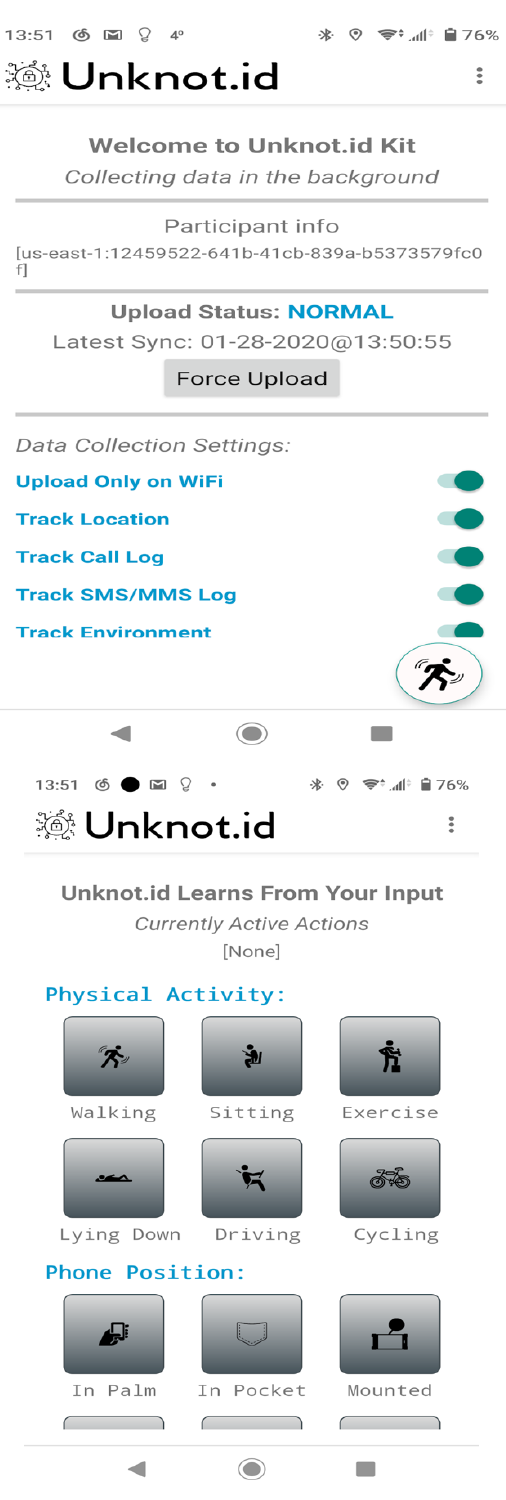
Figure A1. Application Home Page